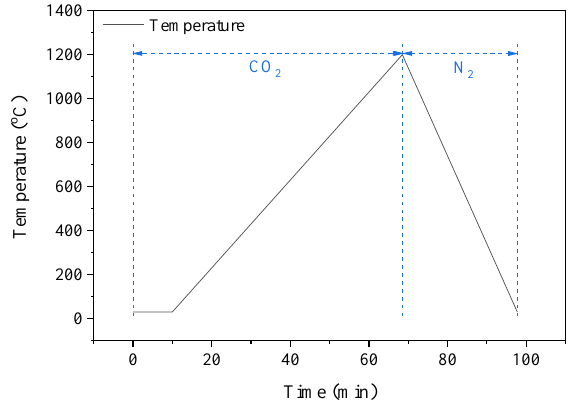
Figure 2. Temperature program of TG (thermal gravimetric) analysis.